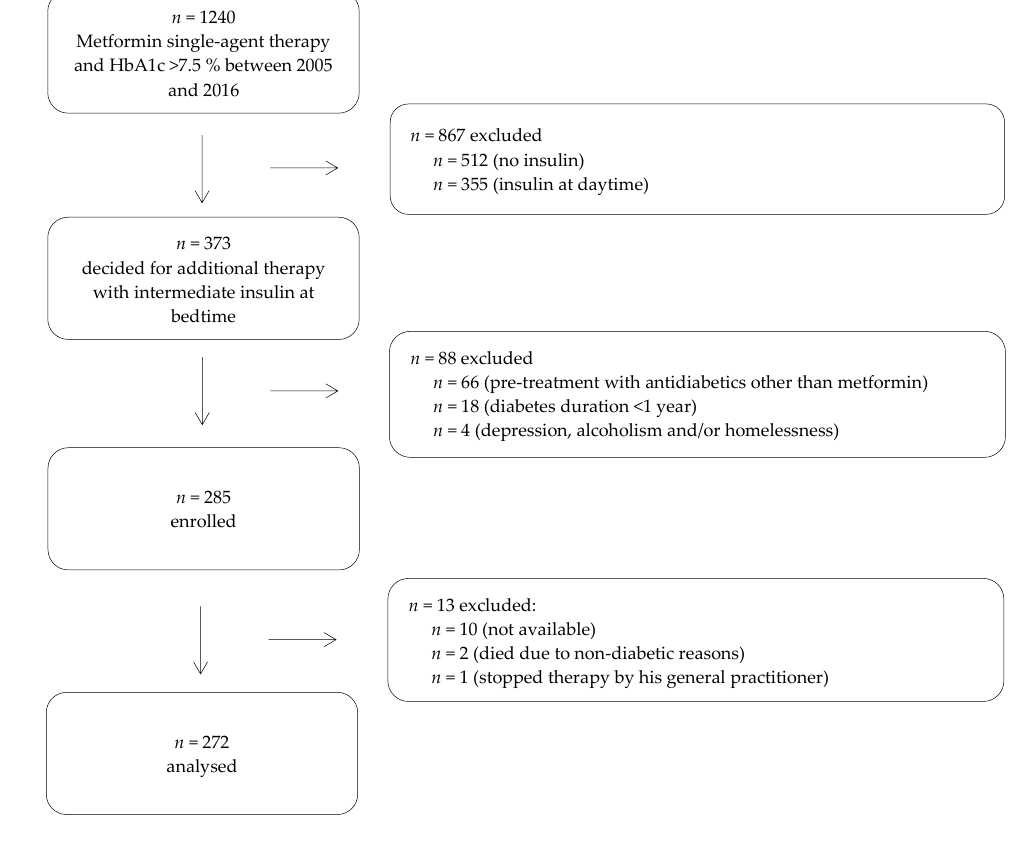
Figure 1. Study Design. Table 1. Baseline characteristics of study